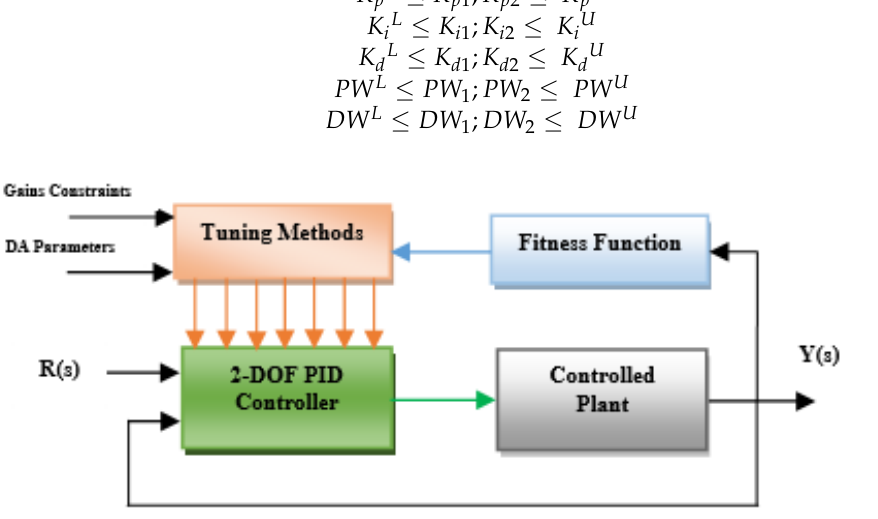
Figure 3. Tuning process of the parameters using IB-WGFF.